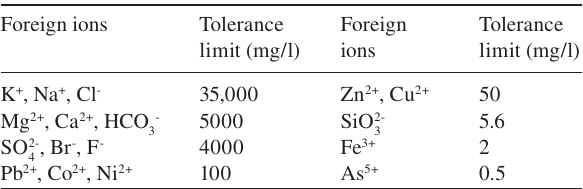
Figure 8 The calibration curves prepared at different